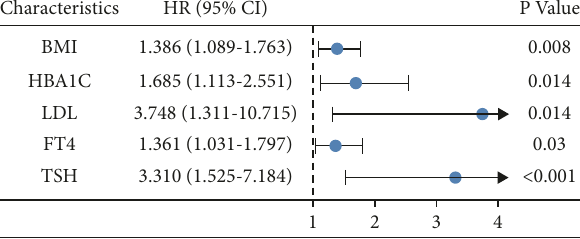
Figure 1: Logistic risk regression model: risk factors for nonal- coholic fatty liver disease